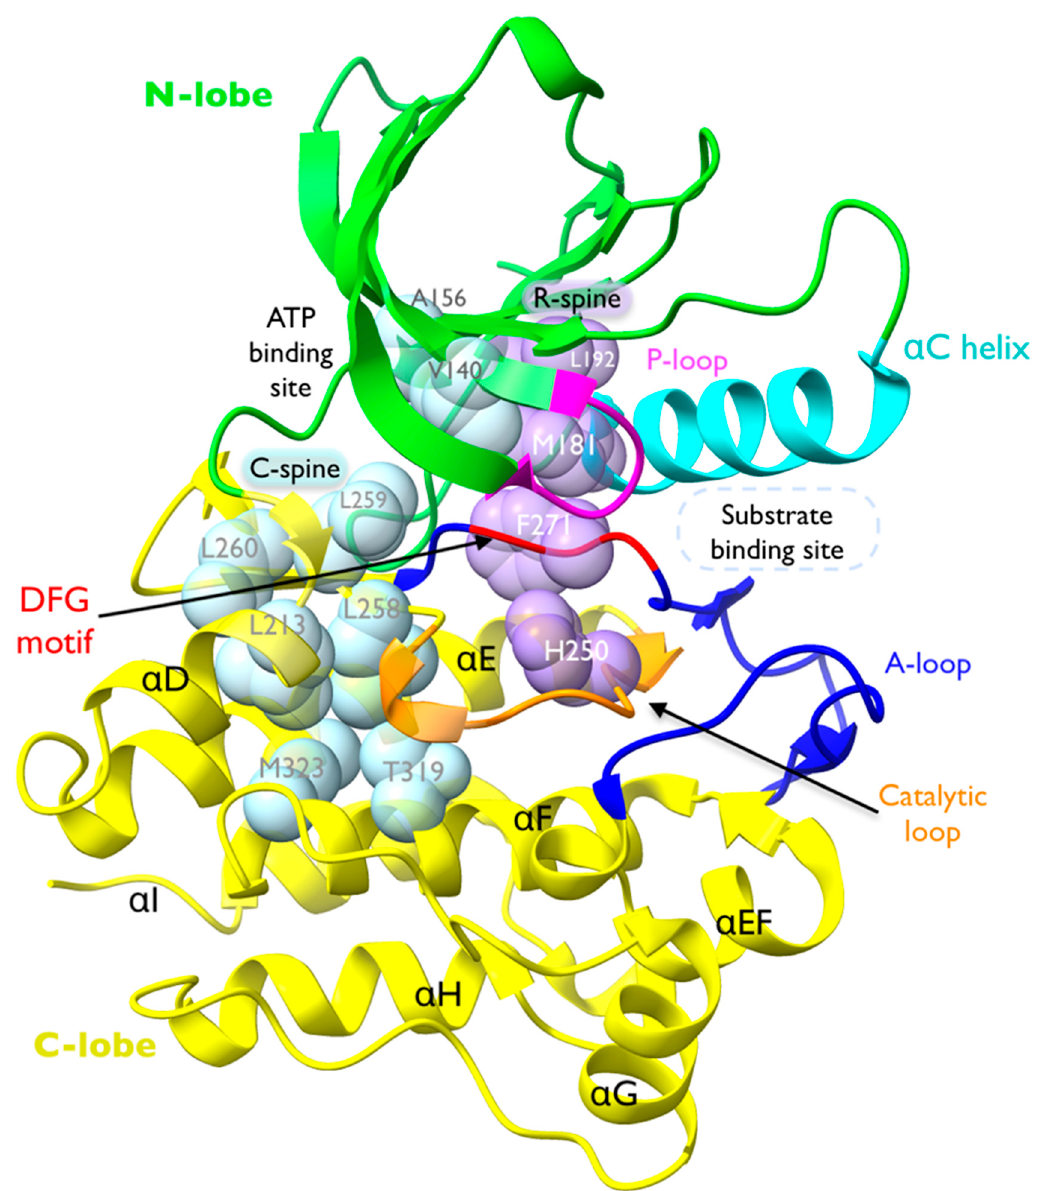
Figure 8. Structure of Ack1 KD. Crystal structure of active Ack1 (PDB: 4EWH). The bi-lobal fold of the kinase domain is highlighted with the N-lobe in green and the C-lobe in yellow. The universally conserved α C-helix is shown in cyan. The phosphate-binding loop (P-loop) is colored magenta. The activation loop (A-loop, blue) encompasses the DFG motif (red), which contributes to ATP binding. The catalytic loop is shown in orange. The residues comprising the catalytic spine (C-spine) and the regulatory spine (R-spine) are shown in light blue and light purple space-filling sphere models, respectively.